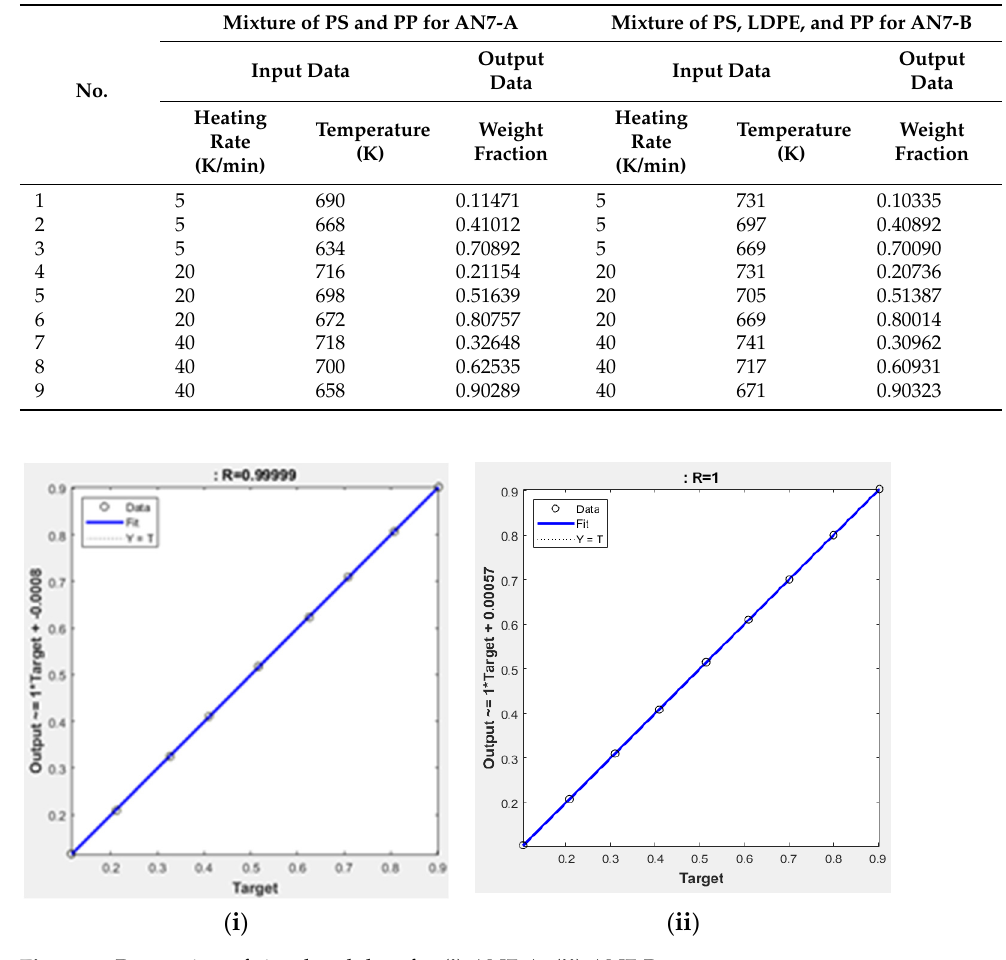
Figure 6. Regression of simulated data for ( i ) AN7-A, ( ii ) AN7-B. Table 8. Statistical parameters for the simulated data of AN7-A and